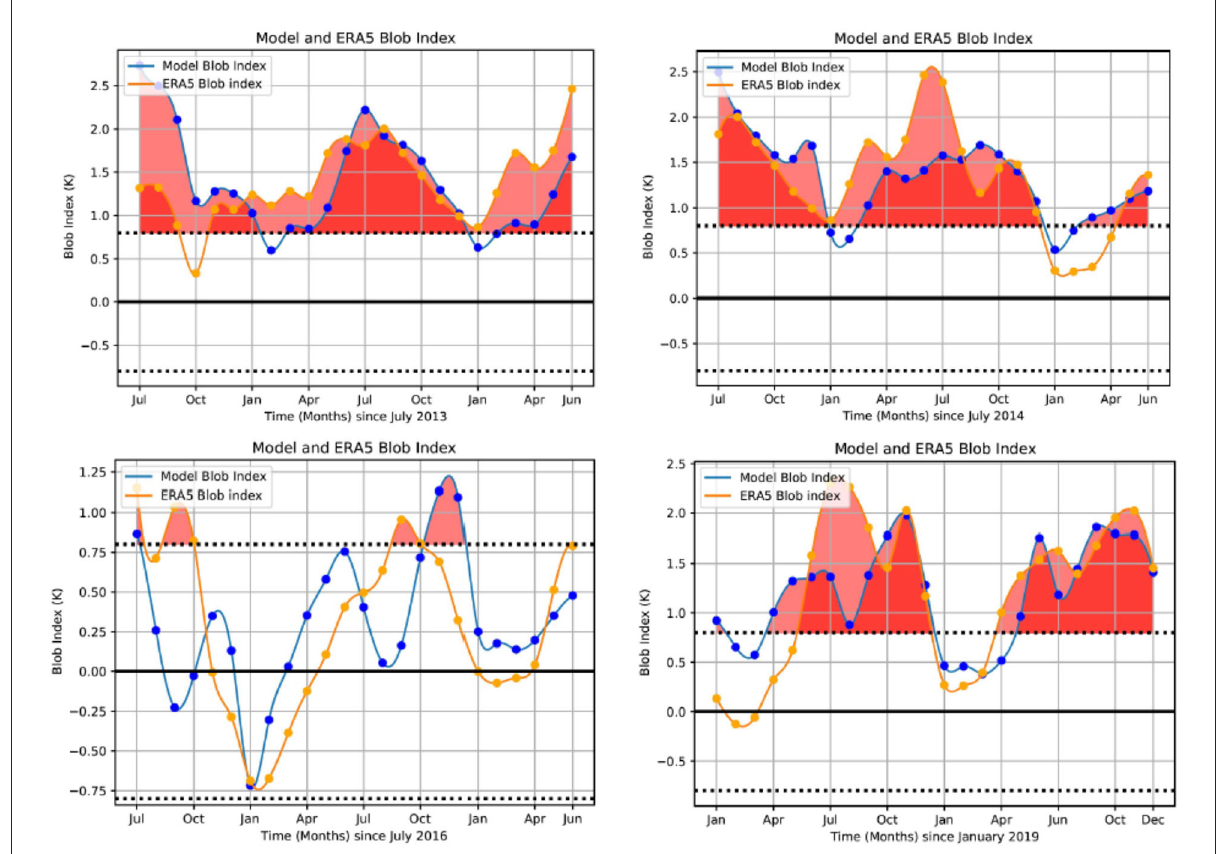
FIGURE15 Model predictions of the Blob index over a 24 month period commencing in July 2013, 2014, 2015, and January 2019 compared with the Blob index, defined as the monthly average SST computed over the region 34 ◦ N-47 ◦ N and 147 ◦ W-128 ◦ W, calculated from the monthly mean ERA5 SST data. We include the two-sided 95% confidence interval. We focus on the period January 2014-May 2021 with the significant ocean warming events in 2014 and 2015 captured in the top two panels. The winter cooling in 2016–2017 and the warming events in 2019 and 2020 are presented in the lower